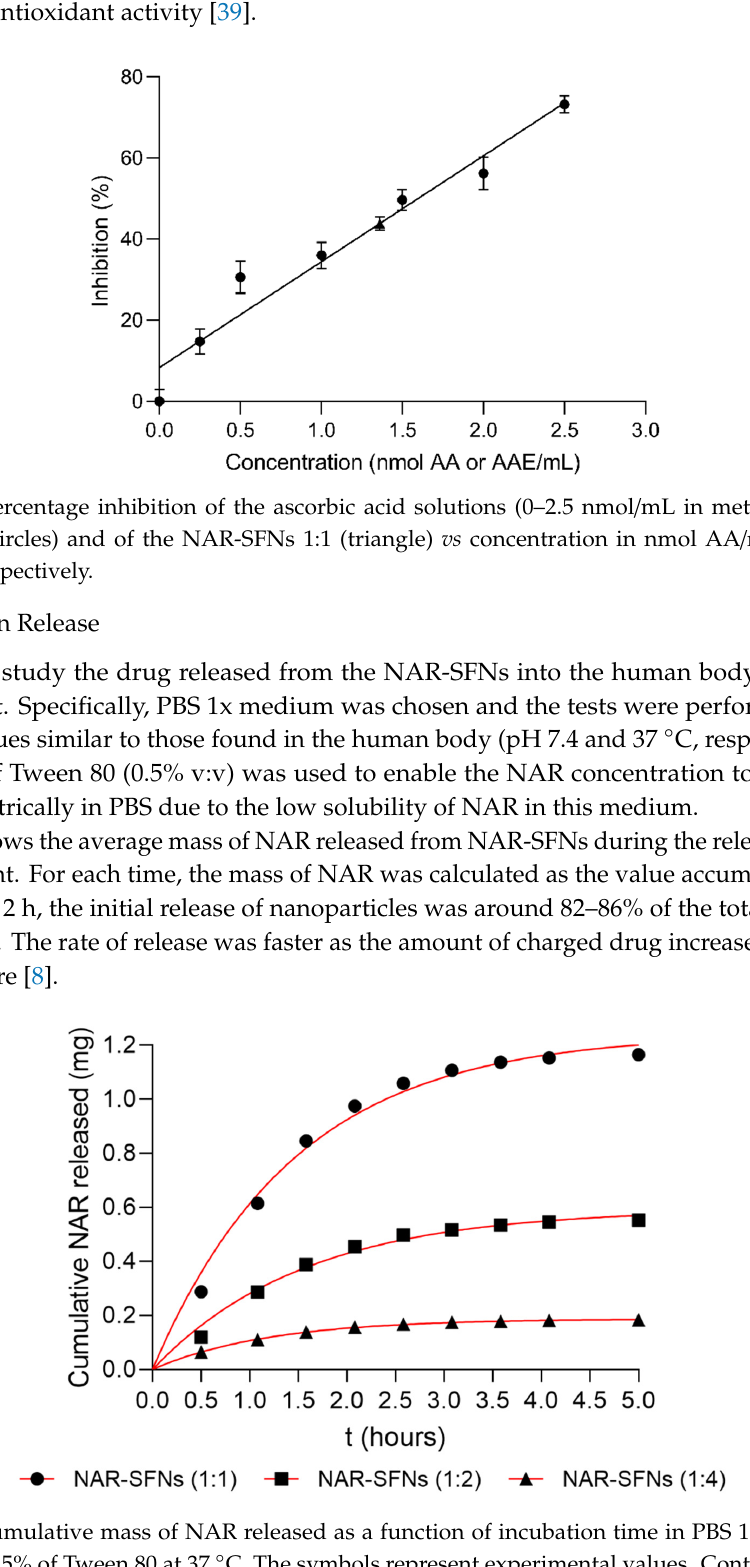
Table 3. Release models of NAR-SFNs. Model